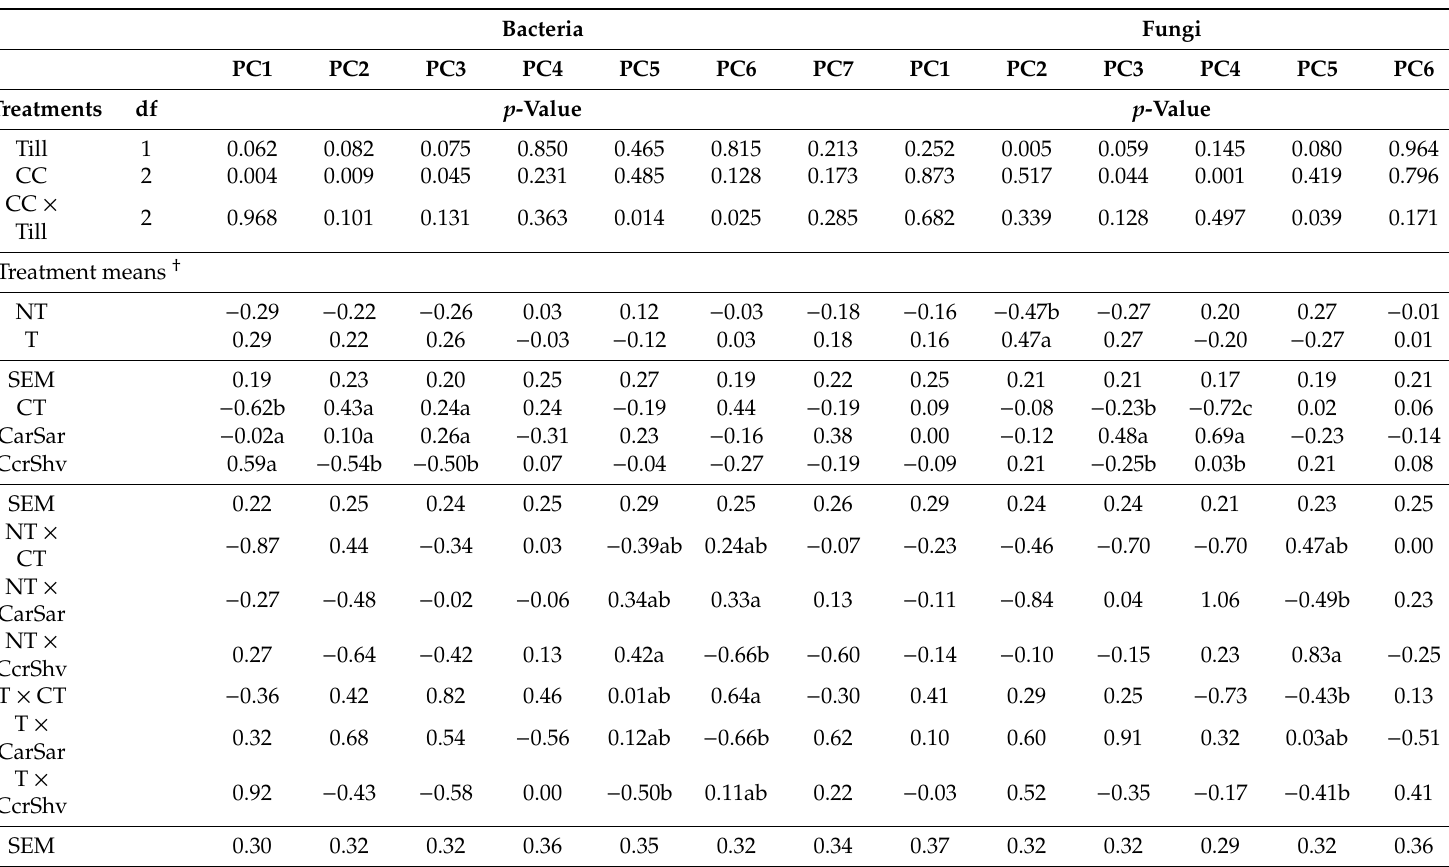
Table 4. Analysis of variance (ANOVA) results for the e ff ects of cover cropping (CC), tillage (Till), and their interaction (CC × Till) on each group of principal components (PCs) extracted from the bacteria and fungi taxa data sets, which comprised bacterial and fungal indicator OTUs, respectively. The probability values of the treatment e ff ects and degrees of freedom (df) are shown on the top rows. The treatment mean values and their standard errors are presented below. For each taxon and within a given column, treatment mean values followed by the same lowercase letter were not statistically di ff erent ( α =